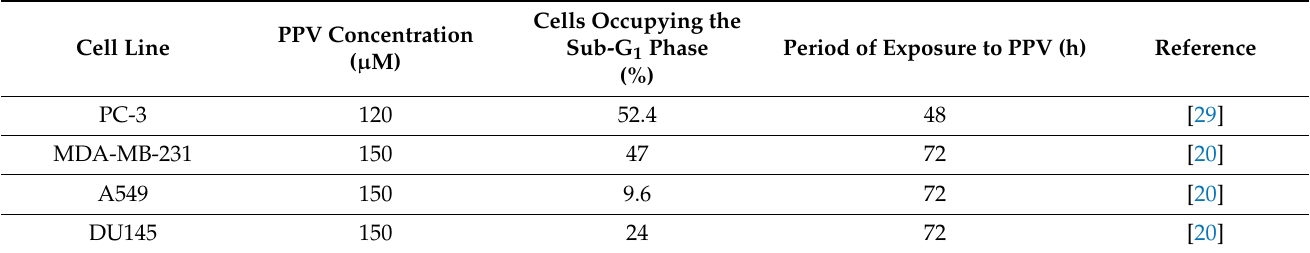
Table 3. A summary of the effects of different concentrations of PPV on the percentage of cells occupying the sub-G 1 phase in tumorigenic and non-tumorigenic